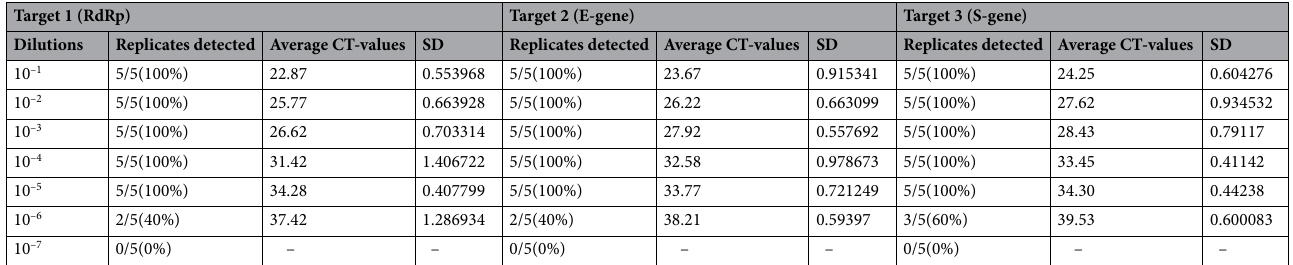
Table 1. Average C t values obtained for three target regions from a series of 7 tenfold serial dilution of a clinical specimen previously detected SARS-CoV-2 positive (SC005G) using Meril covid-19 detection kit.